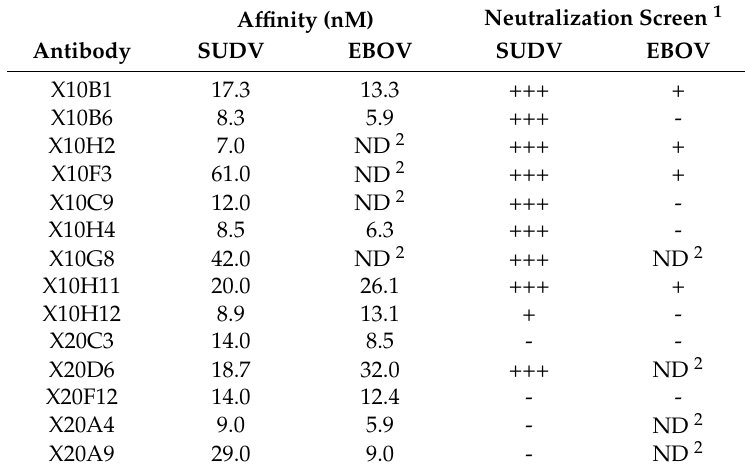
Table 1. Affinity and neutralization screening. Affinities were measured by surface plasmon resonance (SPR) utilizing Biacore utilizing the glycoprotein for each virus coated to the chip. Neutralization screenings were set at 50 ug/mL for each antibody to either SUDV Boniface or EBOV Kikwit and assessed by plaque reduction and neutralization titer (PRNT) assay.